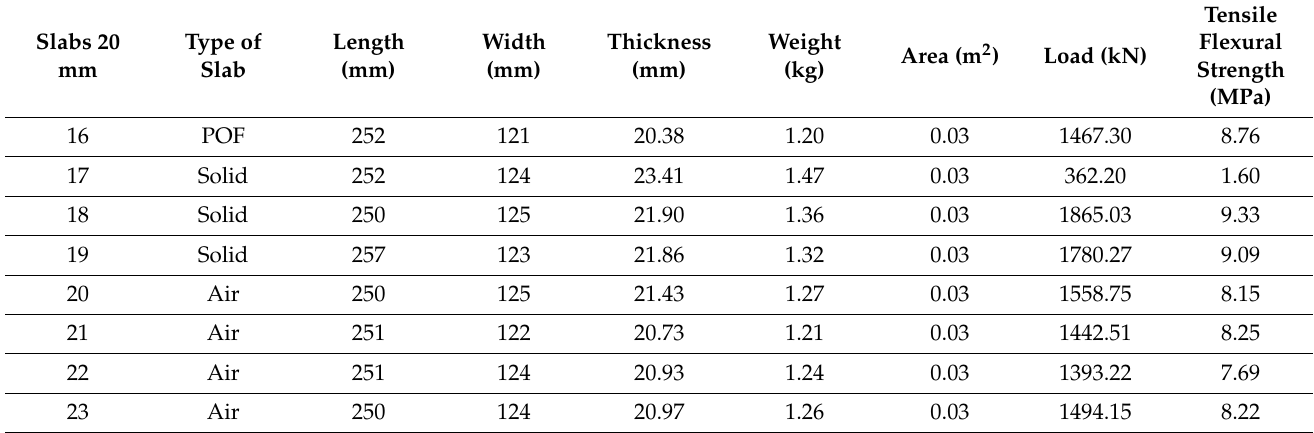
Table 13. Properties of slabs 20 mm thick for measuring tensile flexural strength.